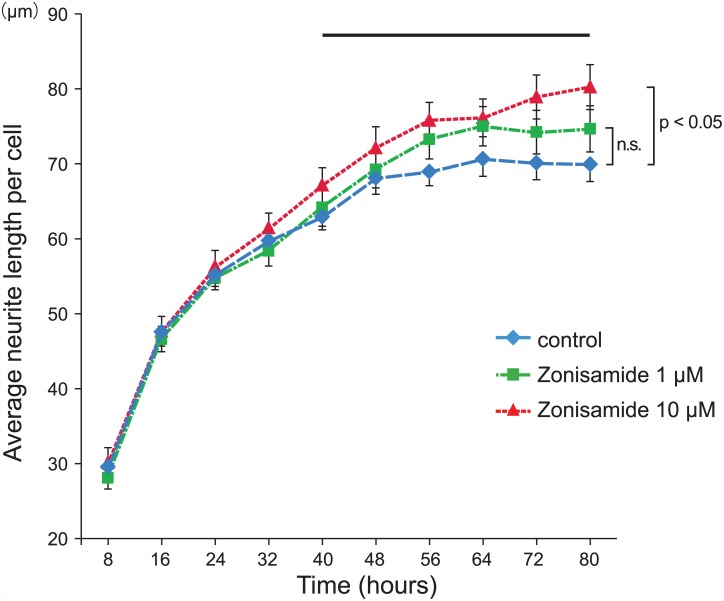
Temporal profile of zonisamide-induced neurite elongation of primary motor neurons.Average neurite lengths of differentiation-induced primary motor neurons were automatically measured every 8 h by the IncuCyte. Mean and SE of the average neurite length per cell in three culture dishes are indicated. The two-way ANOVA analysis was applied from 40 to 80 h (the bar on the top) after adding the differentiation medium. The statistical difference is indicated on the right side of the lines. n.s., not significant.